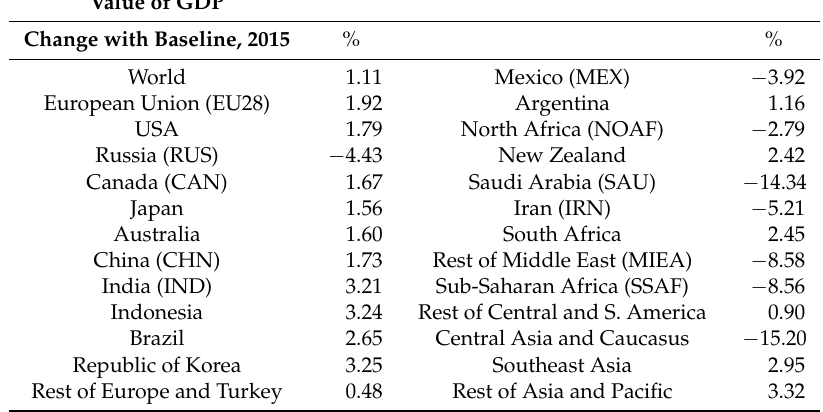
Table 5. Impact of a 60% oil price drop on real GDP. Source: JRC-GEM-E3 model.